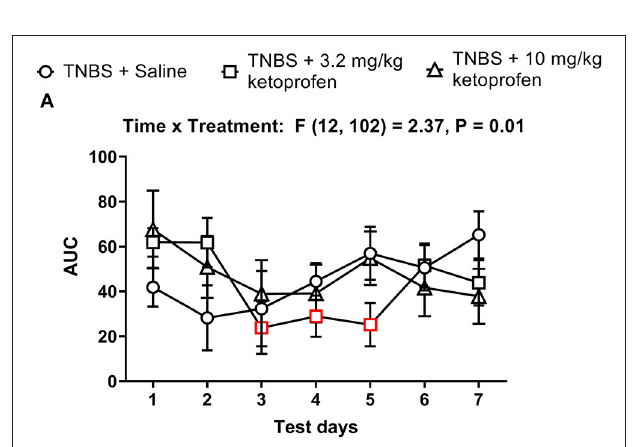
FIGURE 14 | Time dependent effect of Ketoprofen on TNBS-induced nesting. (A) The area under the curve (AUC) of nesting scores recorded daily in mice treated with TNBS and saline, 3.2 or 10 mg/kg/day ketoprofen s.c. Red points indicate significance ( P < 0.05) vs. day one by repeated measures two-way ANOVA with Dunnett’s test.